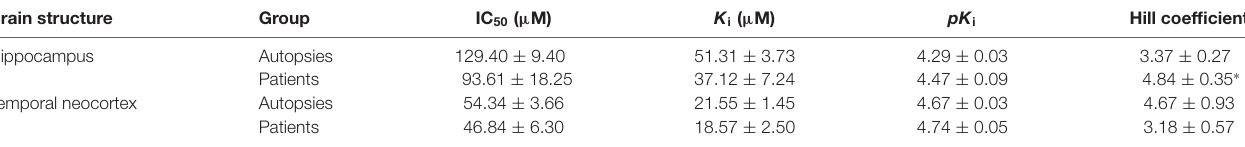
TABLE 3 | Data obtained from the radioligand displacement assay in the hippocampus and temporal neocortex of autopsies and patients with drug resistance mesial lobe epilepsy.